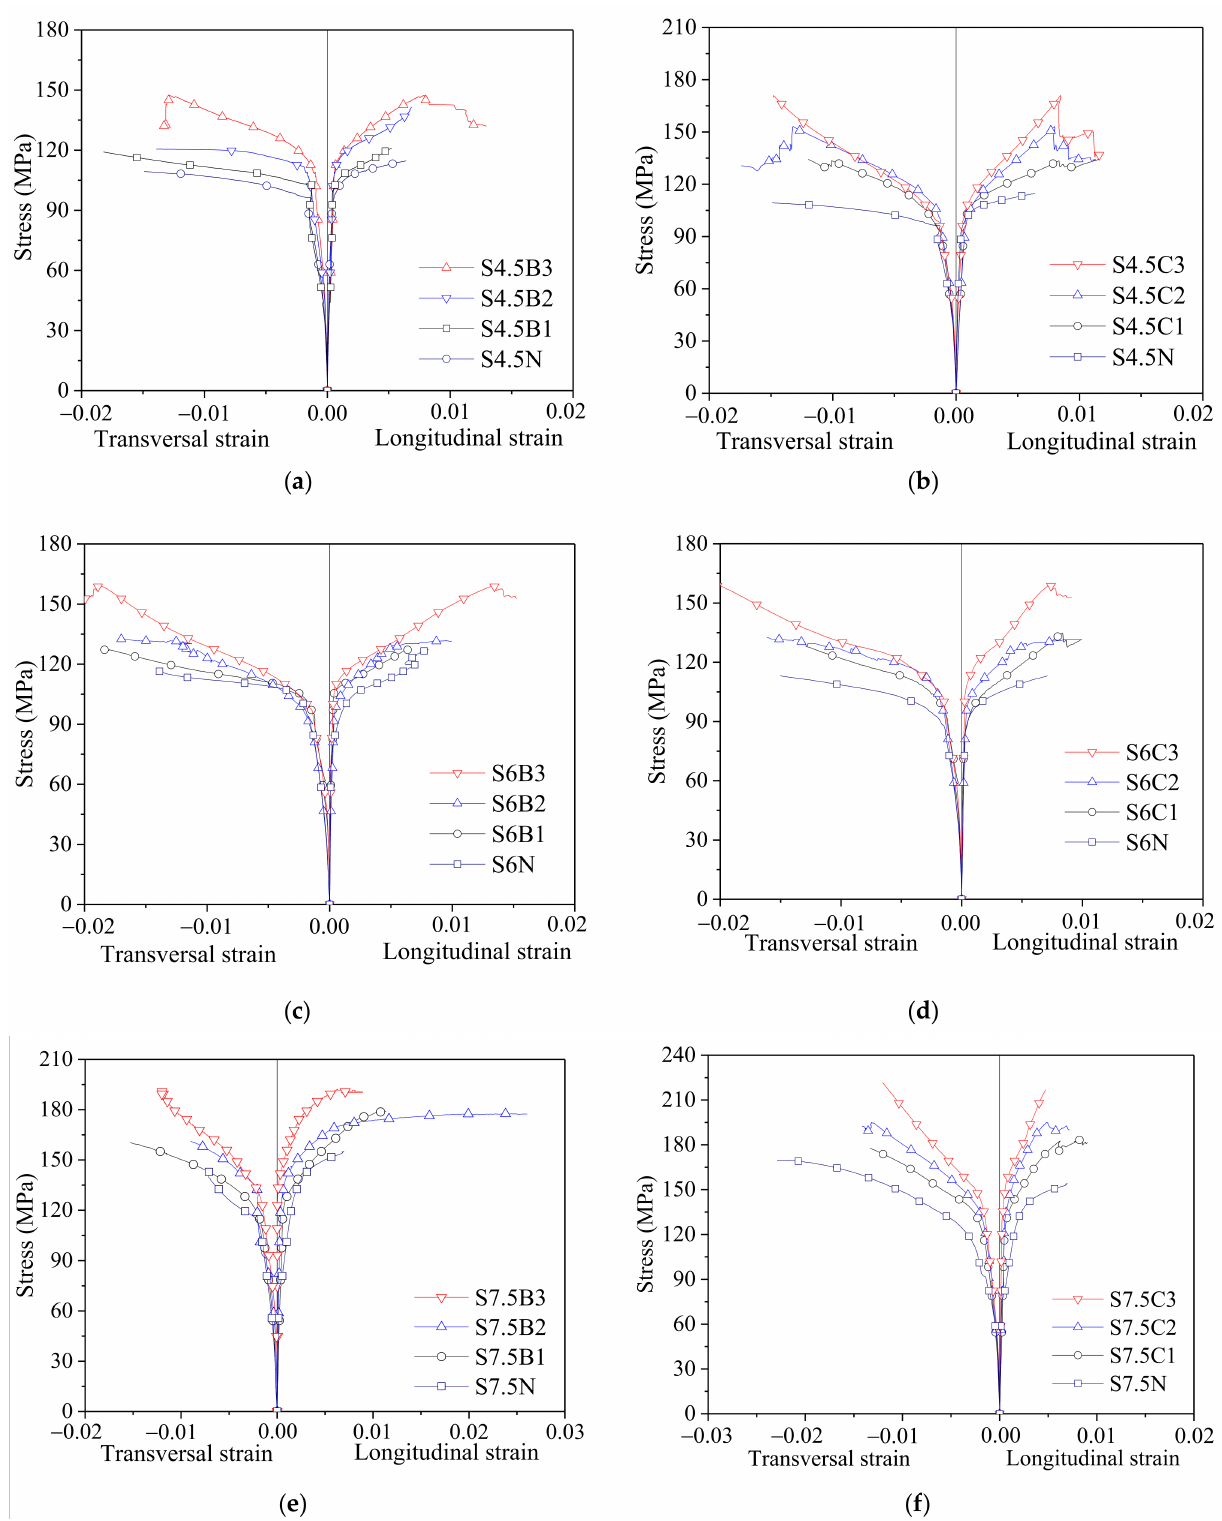
Figure 6. Stress-local strain curves of specimens. ( a ) S4.5B series. ( b ) S4.5C series. ( c ) S6B series. ( d ) S6C series. ( e ) S7.5B series. ( f ) S7.5C